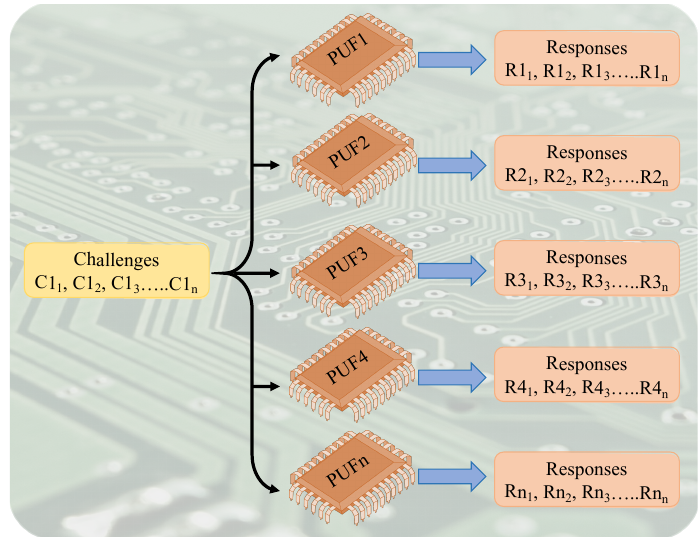
Figure 2. Challenge–response pair in PUF.